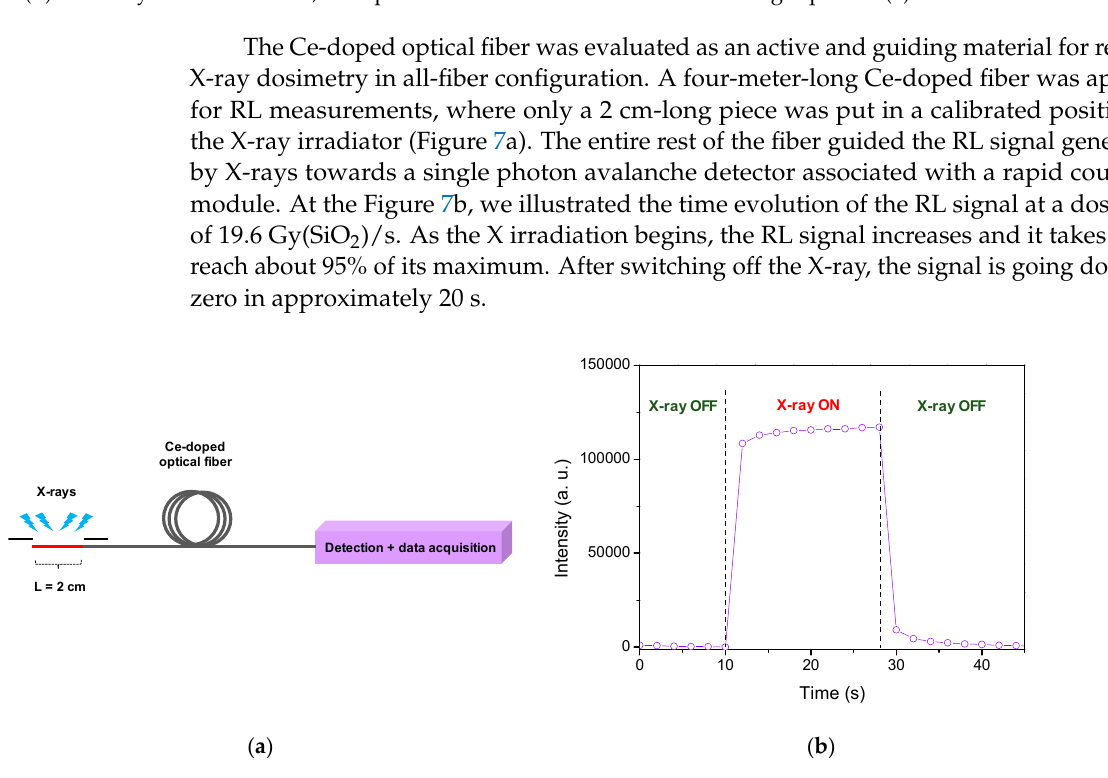
Figure 8. Averaged RL signal of the Ce 3+ -doped optical fiber against the X-ray dose rate. In the inset, a plot of the ratio between fit and experimental intensity values as a function of the dose rate.